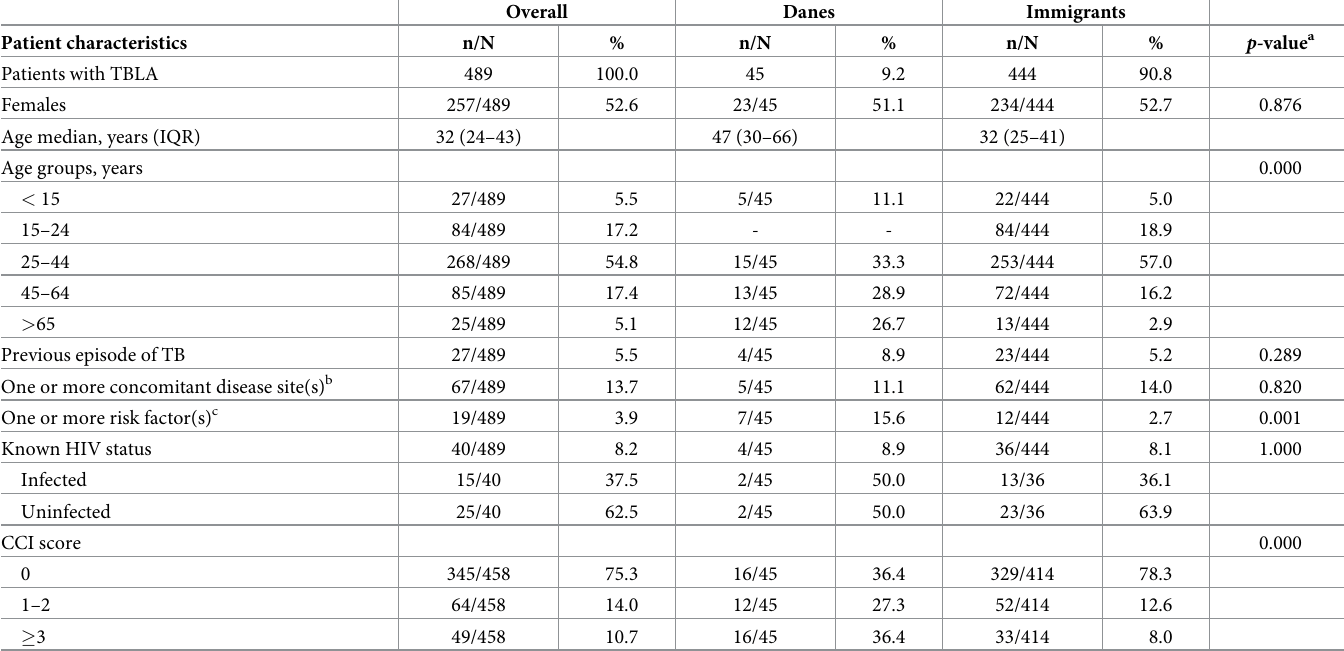
Table 1. Patient demographics. Demographic characteristics and Charlson comorbidity index (CCI) scores for tuberculous lymphadenitis patients in Denmark from 2007 through